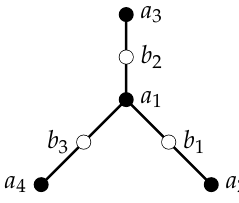
Figure 2. The induced graph S ( K 1,3